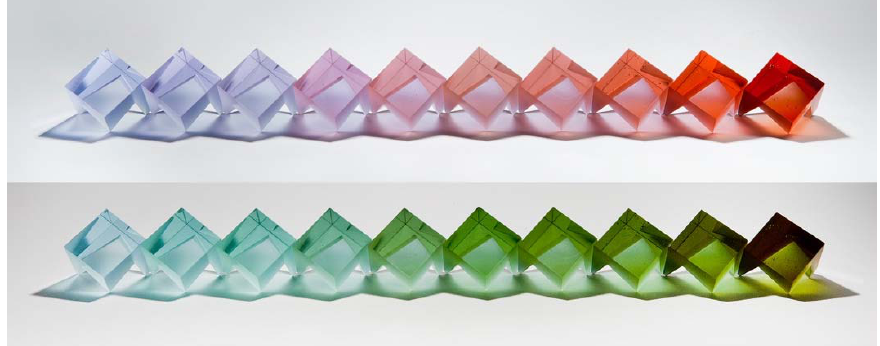
Figure 6. Heike Brachlow, Theme and Variations I, 2009. Line blend, Bullseye glass doped with neodymium, cerium, and titanium oxides in the ratio 2:1:1. Photographed in incandescent (top) and fluorescent light by Ester Segarra, courtesy of the artist.